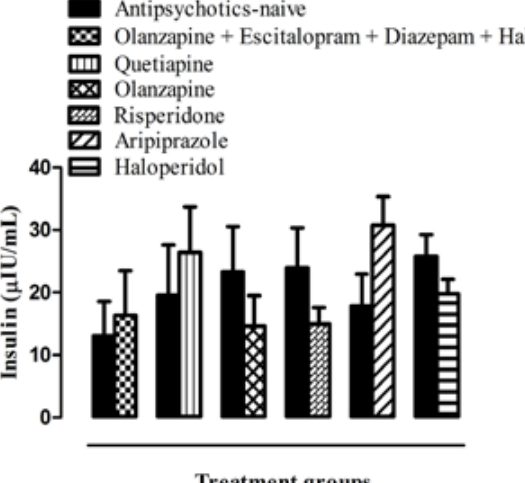
FIGURE 4 - Effect of selected antipsychotics on c-peptide: Antipsychotic-naïve patients were put on olanzapine in combination with esitalopram, diazepam (STAT, I.V) and haloperidol (STAT, I.M) (OLEDH, n=8), quetiapine (QUET, n=8), olanzapine (OLAN, n=8), risperidone (RISP, n=8), aripiprazole (n=8) or haloperidol (n=8) in therapeutic doses for an average time period of 39, 40, 45, 38, 30 and 33 days respectively showing no significant change in c-peptide as compared to antipsychotics-naïve patients (ANOVA followed by Bonferroni’s Multiple Comparison Test) (P >